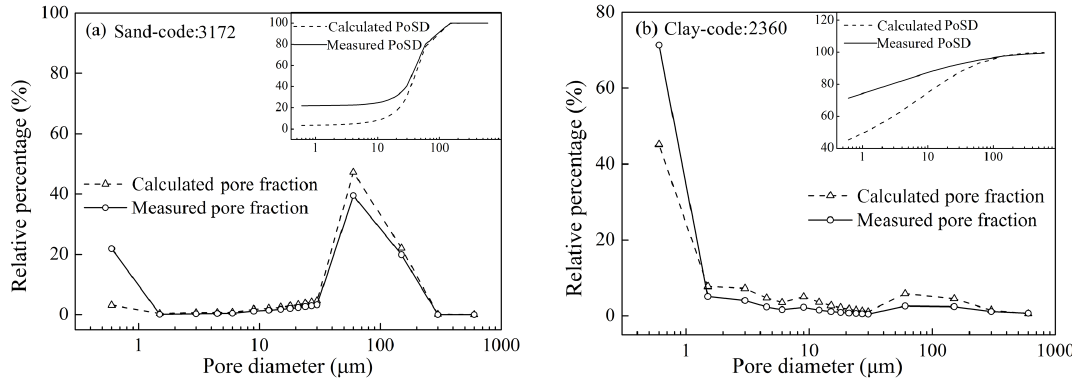
Figure 1. Measured vs. calculated pore volume fraction curves using the traditional method for (a) sand (code: 3172) and (b) clay (code: 2360). The measured and calculated PoSDs are in the insets at the top of the figures.